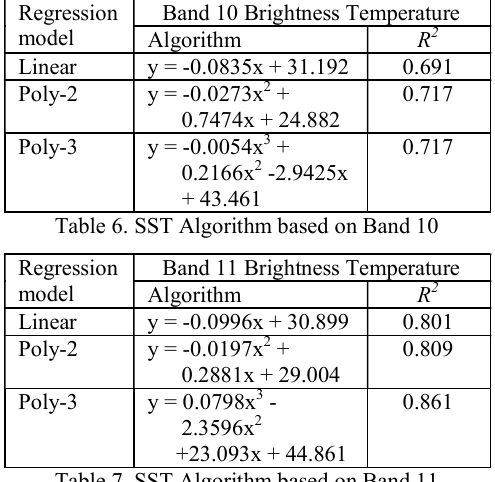
Table 7. SST Algorithm based on Band 11